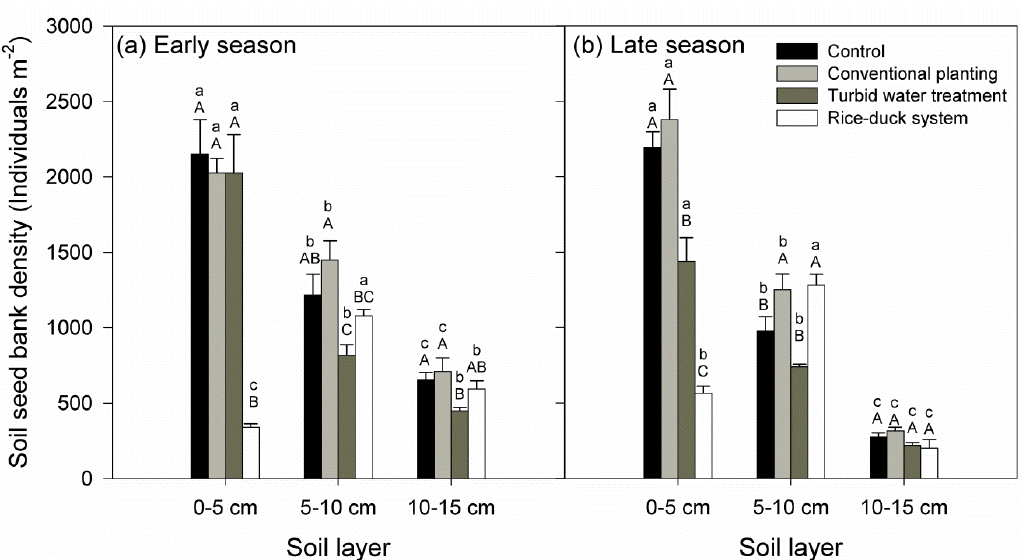
Figure 4. Vertical distribution of soil seed bank in the early ( a ) and late ( b ) seasons of rice growth under the treatments and control. Bars present the mean and error bars present the standard error ( n = 3). Results with the same lowercase letter at the top of the columns are not statistically di ff erent among soil depth and with the same capital letter are not statistically di ff erent among treatments in each rice season at each soil depth. Significance level was set at p < 0.05.